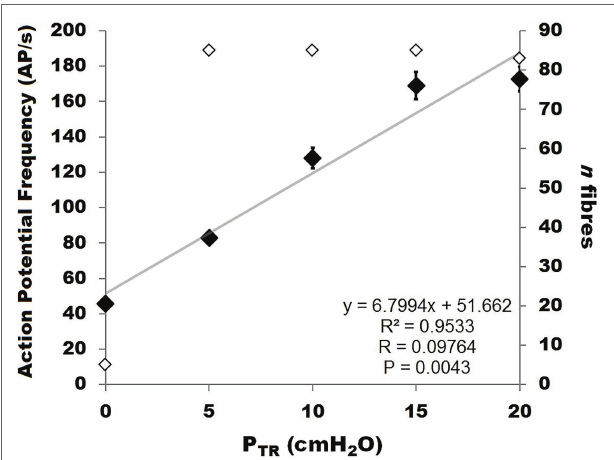
FIGURE 6 | Relationship between murine SAR action potential frequency (AP f ; labeled “action potential frequency”; left Y-axis, black diamonds) and pressure (P TR ) during slow inflation from 0 to 20 cmH 2 O. The data were best fit by a linear correlation between P TR and AP f ( R 2 = 0.9533, p < 0.01). The number of receptors contributing to AP f at each pressure value is indicated on the right Y-axis (open